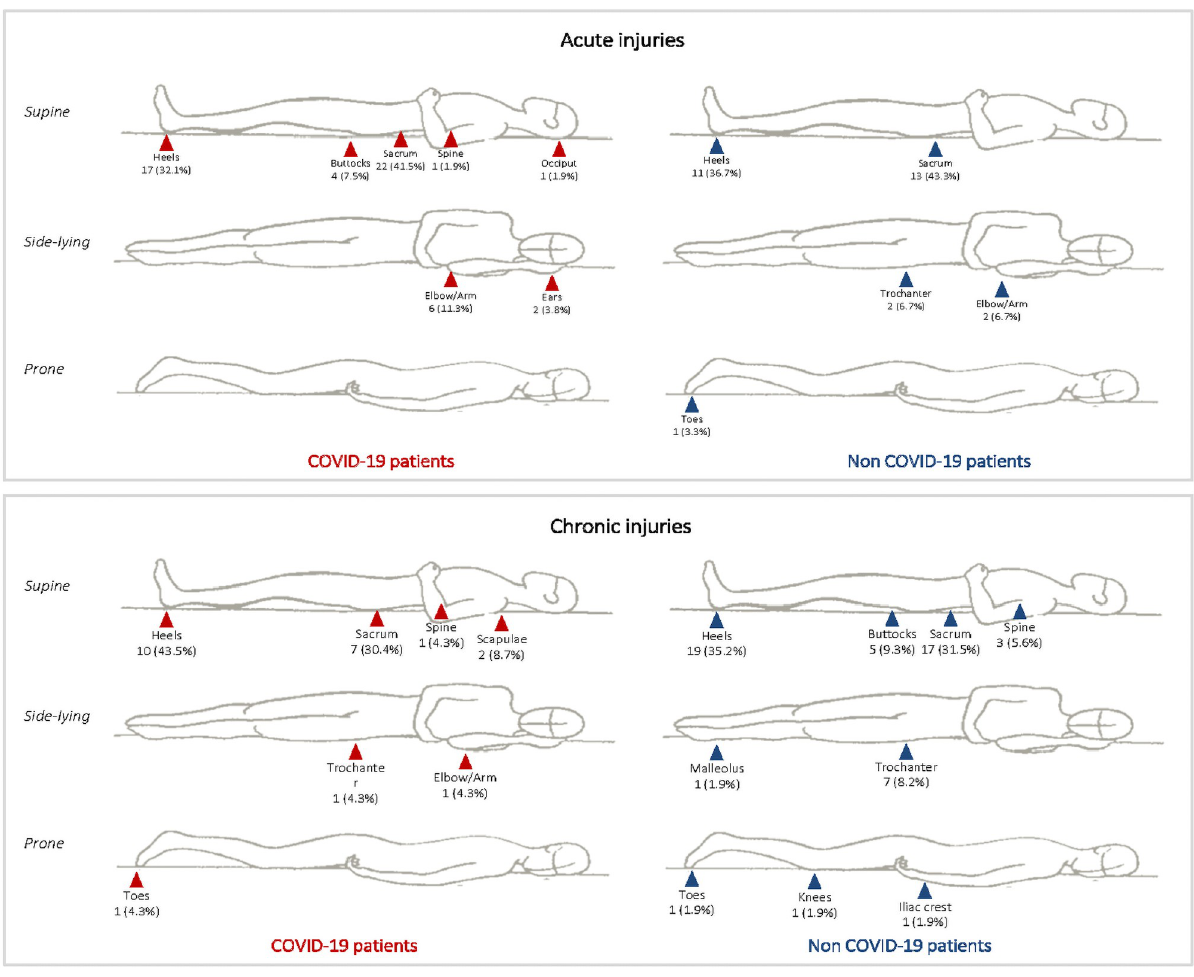
Fig 3. Anatomic location of acute vs. chronic PIs in COVID-19 and non-COVID-19 patients.